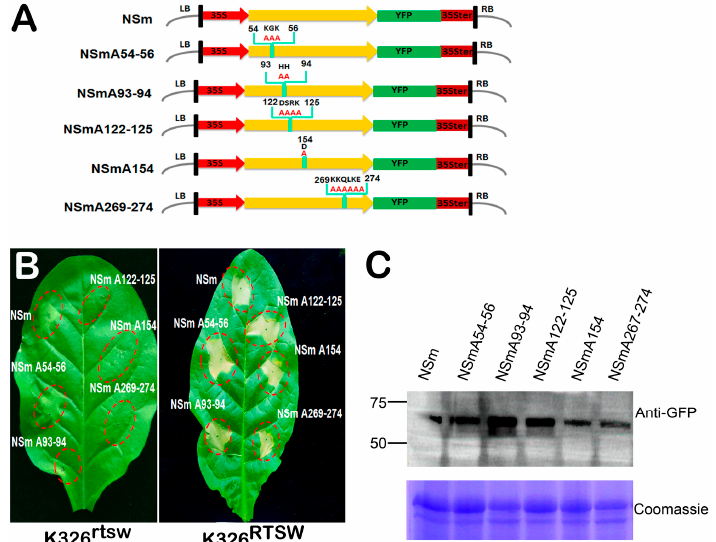
Figure 4. Analysis of the relationship between HR induction and movement functions of TSWV NSm.